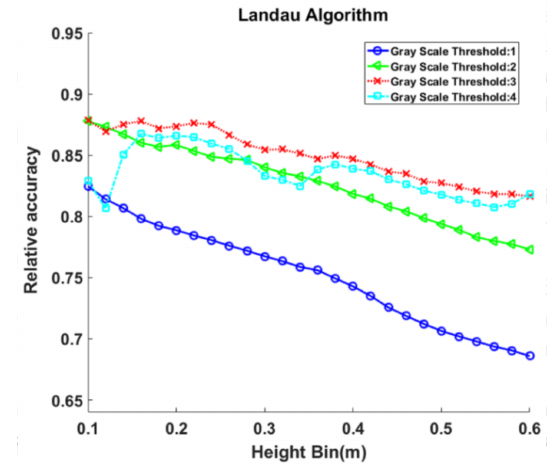
Figure 9. The relative accuracy of Landau algorithm under different height bins and gray scale thresholds in multi-scan mode of the natural secondary forest.